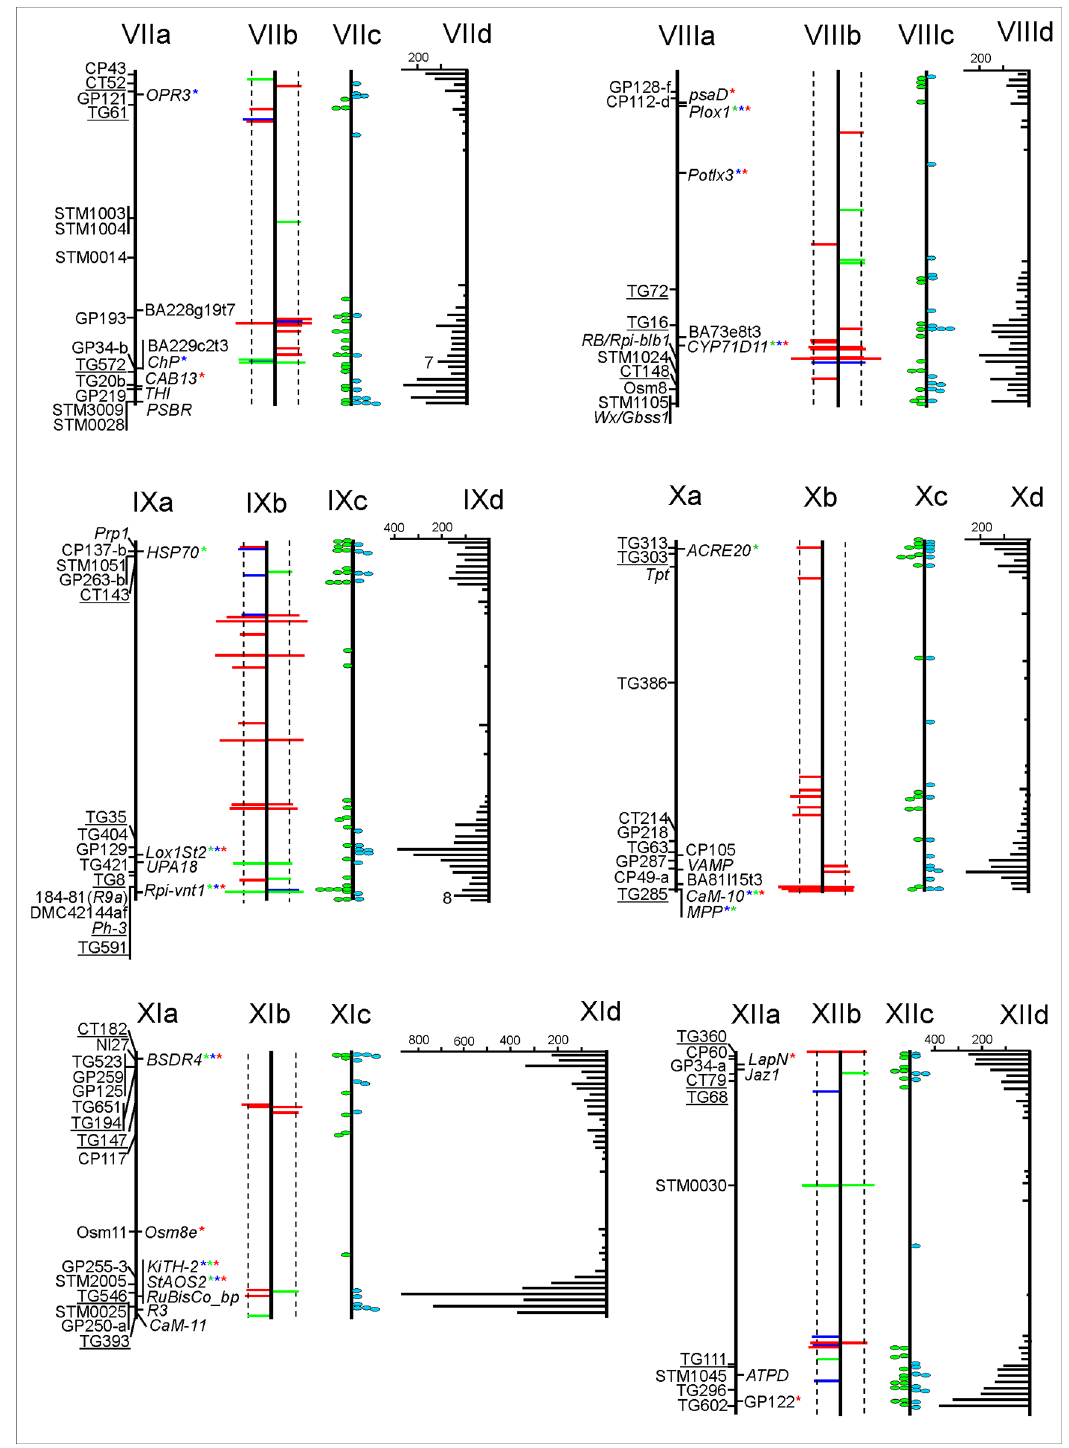
Fig 2. Physical maps of the potato chromosomes VII to XII (pseudomolecules v4.03). Legend as in Fig 1.